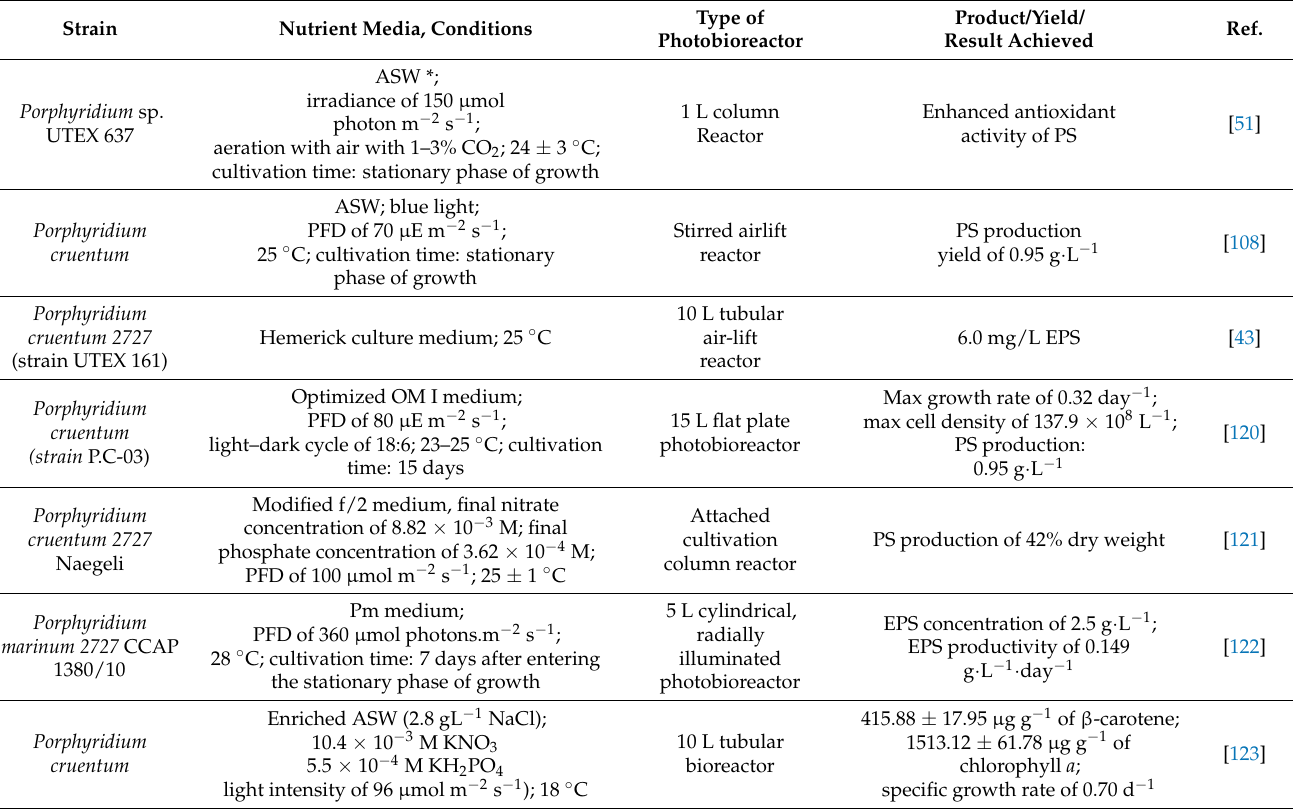
Table 3. Cultivation of strains of Porphyridium in different types of bioreactors: conditions, improved results, and valuable product